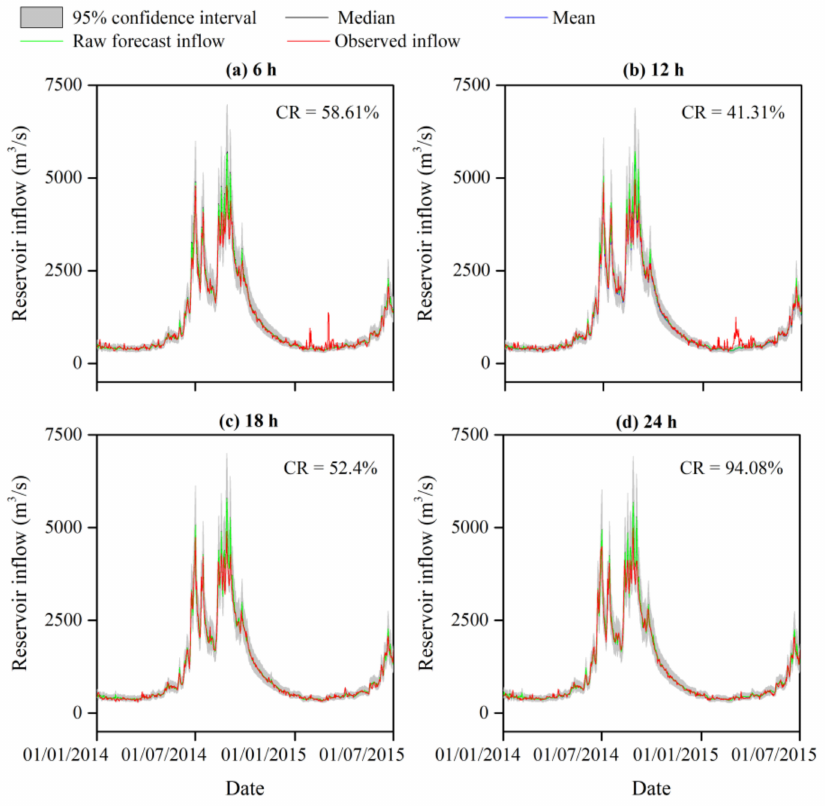
Figure 9. Same as Figure 8 but for the traditional GMD